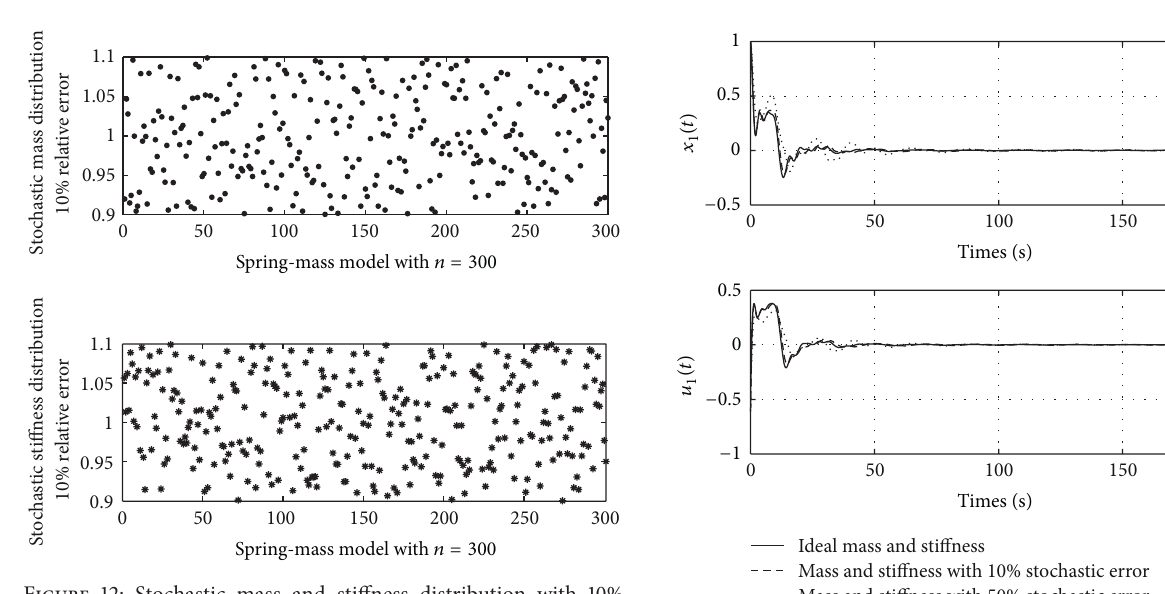
Figure 12: Stochastic mass and stiffness distribution with 10% relative error for the spring-mass model with 𝑛 = 300 .